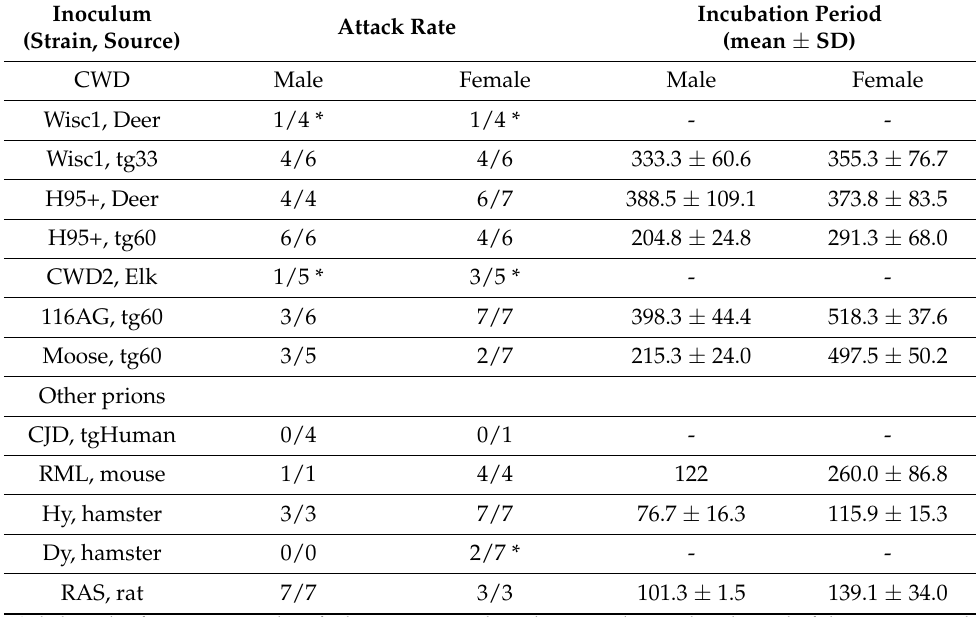
Table 1. Attack rate and incubation periods in the transgenic beaver